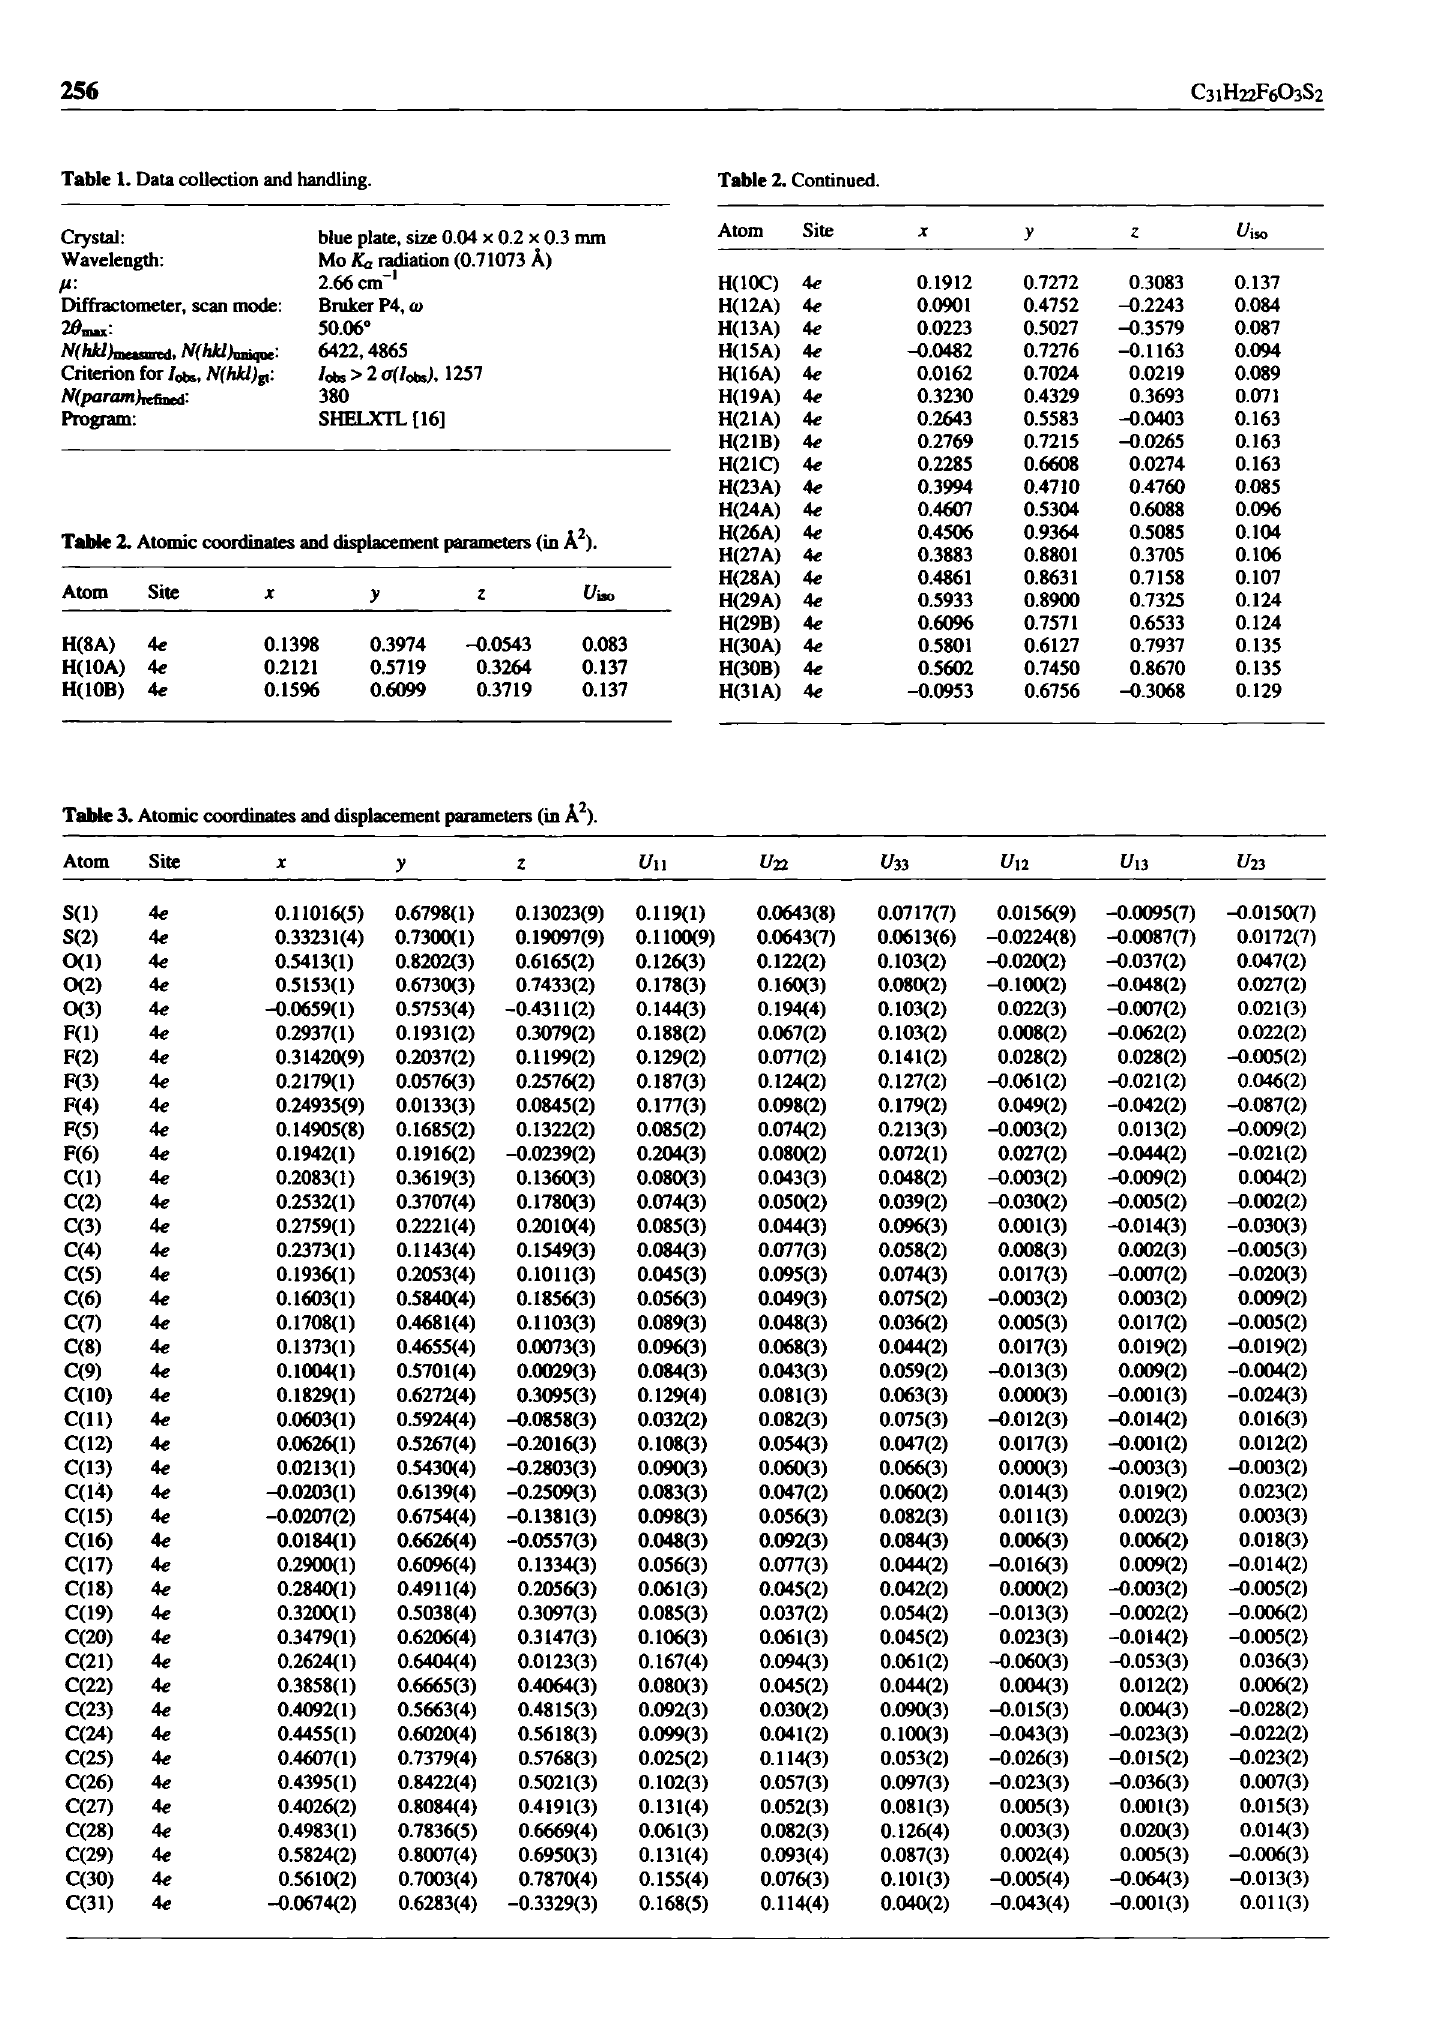
Table 1. Data collection and handling.